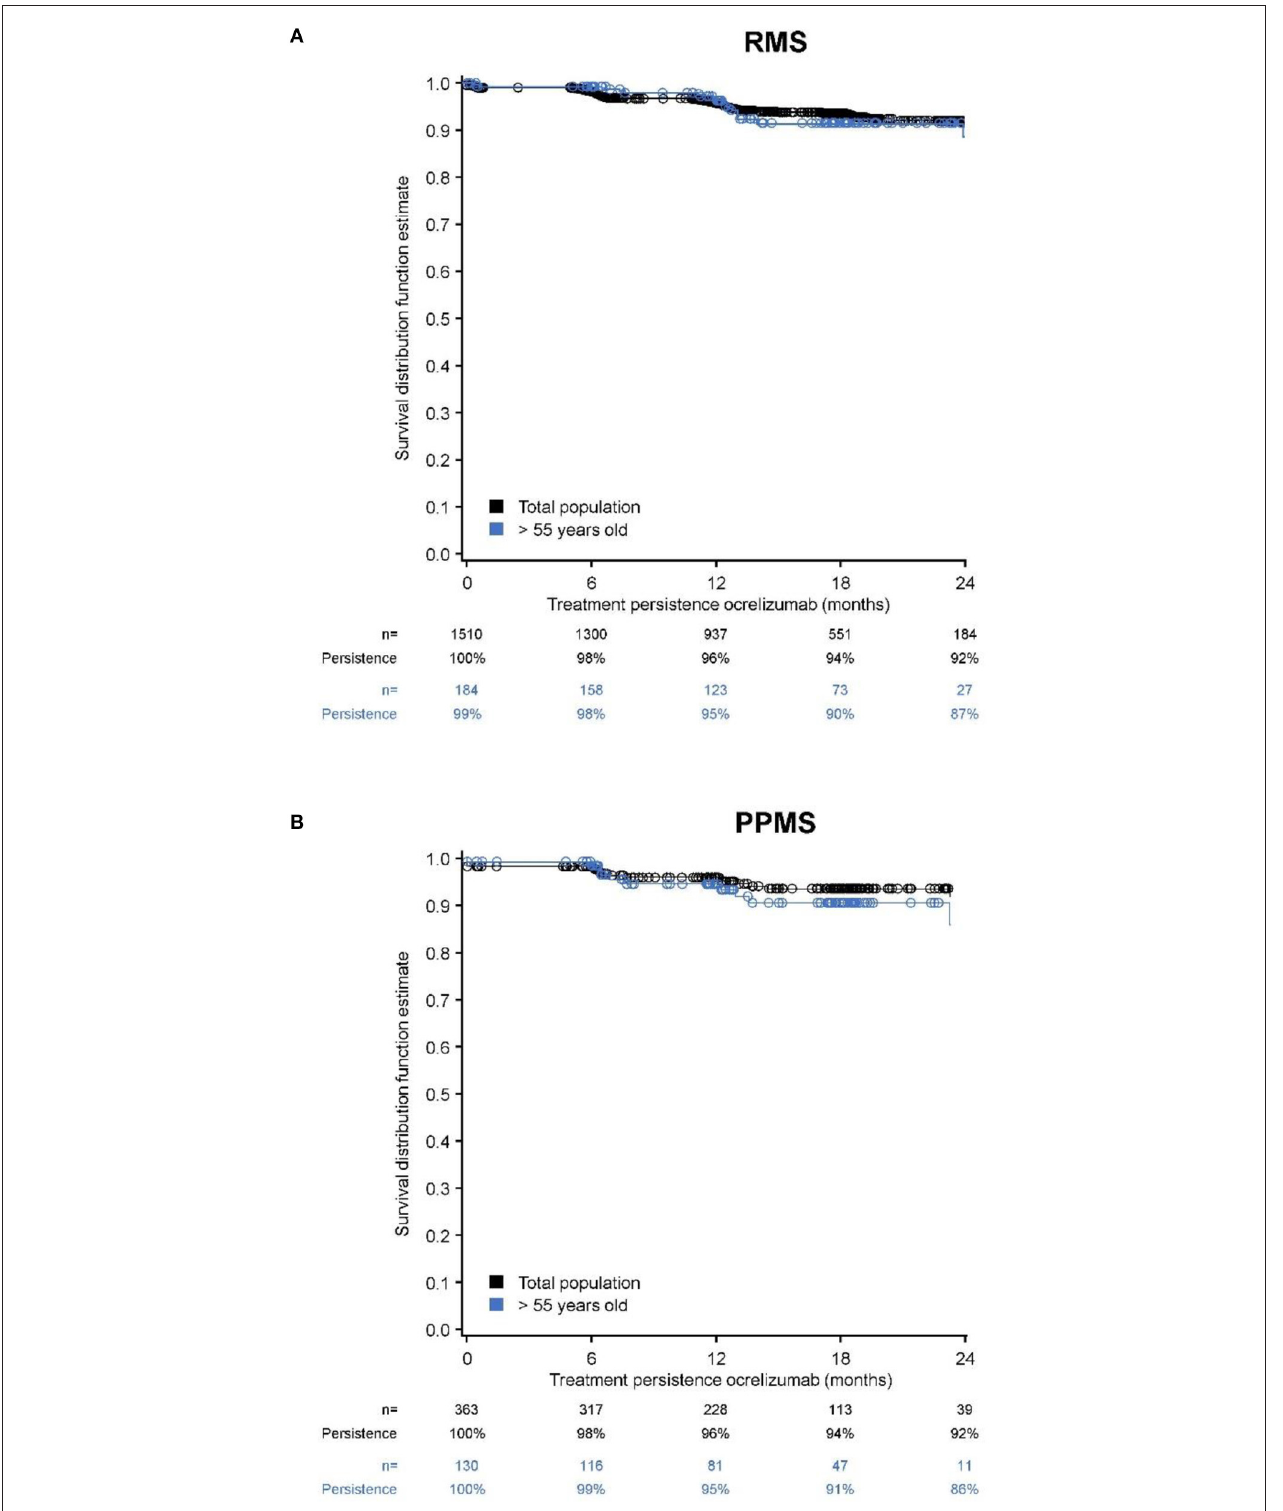
FIGURE 1 | Kaplan-Meier estimates of persistence over 24-months of treatment with ocrelizumab (full analysis set). (A) RMS total + > 55 years; (B) PPMS total + > 55 years.